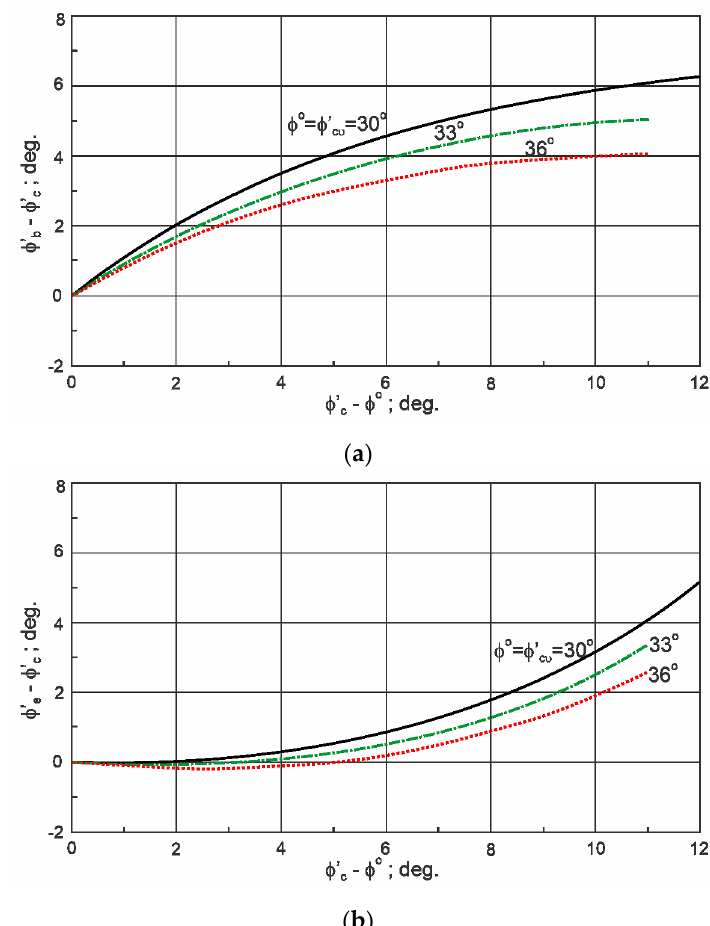
Figure 4. Difference between the friction angle for biaxial testing or triaxial extension testing and the excess of friction angle for triaxial compression testing: ( a ) ''' . cce